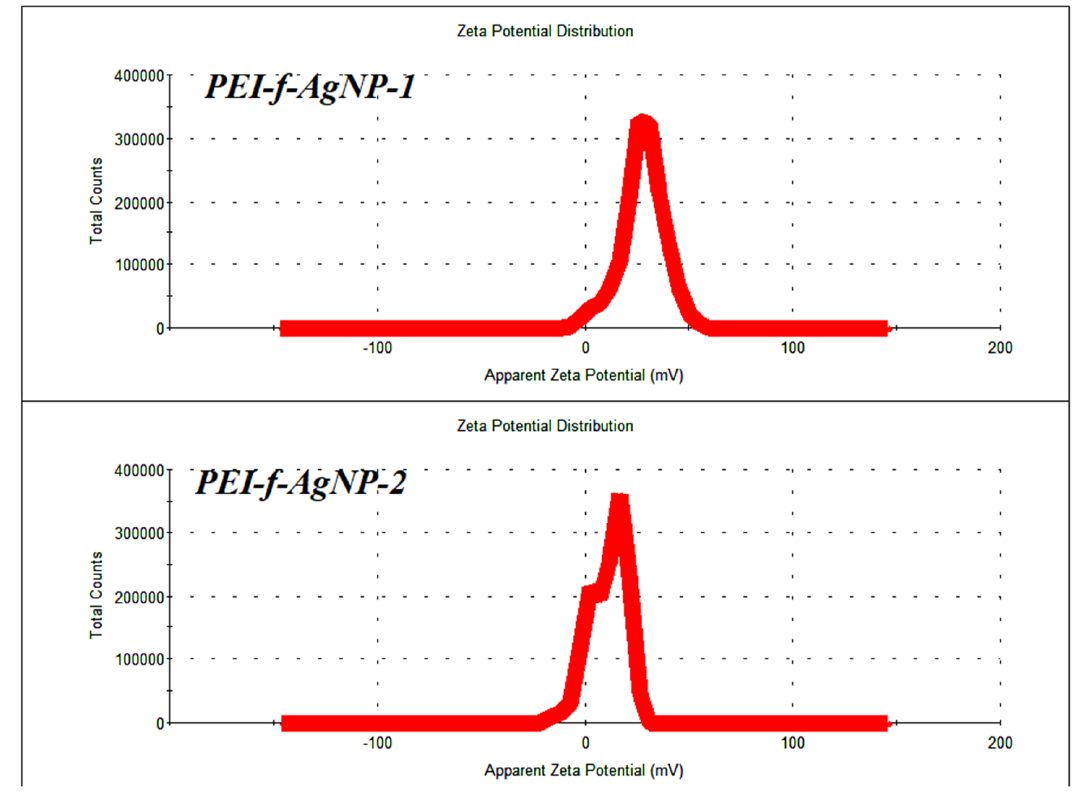
Figure 2. Zeta potential distribution of PEI-f-AgNP-1 and 2.